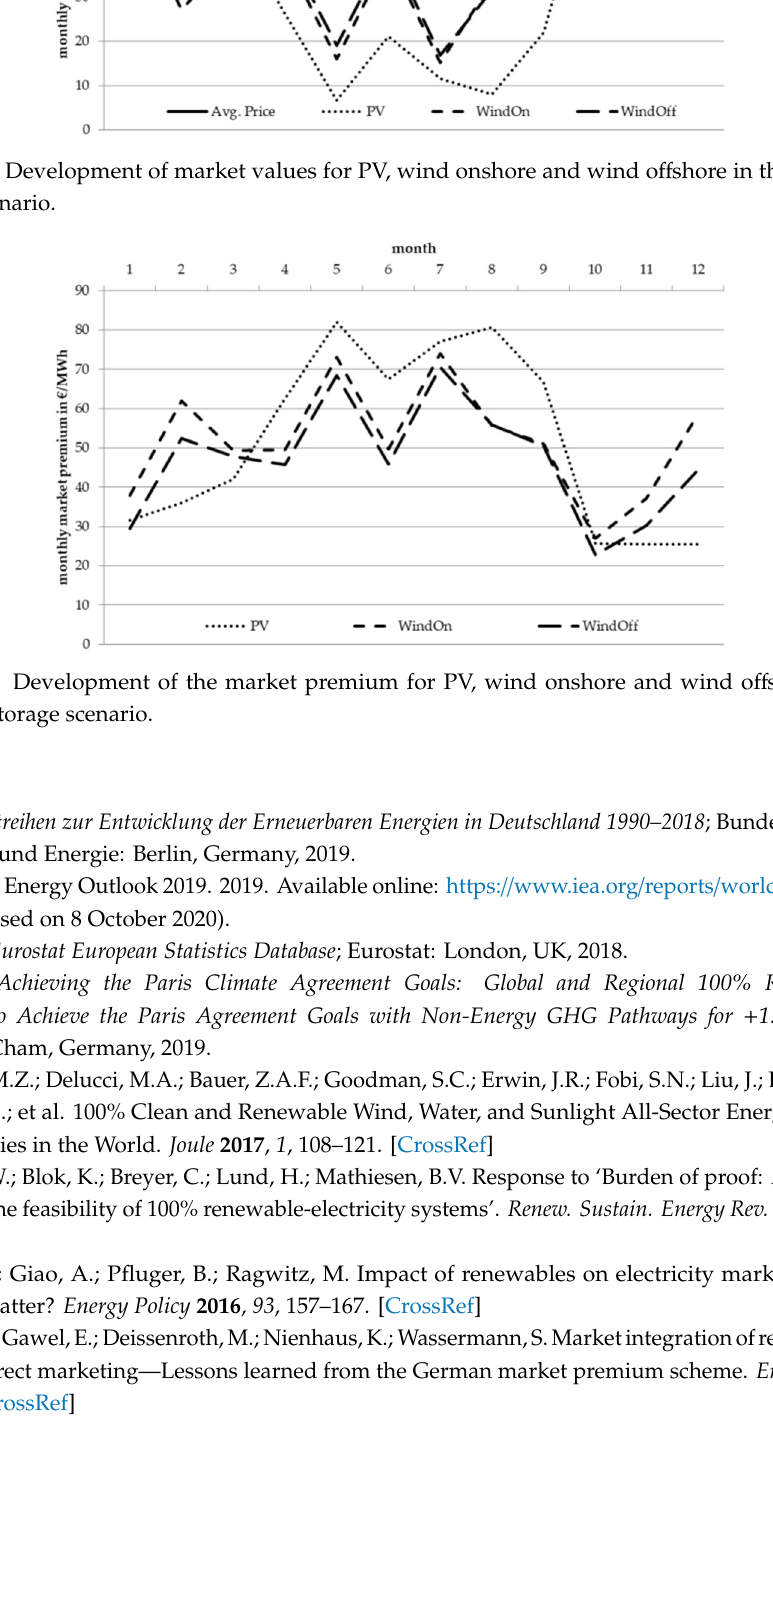
Figure A6. Development of market values for PV, wind onshore and wind offshore in the extended storage scenario.